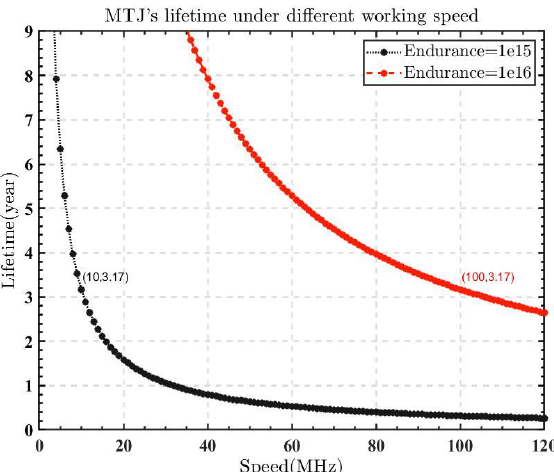
Figure 3. MTJ’s lifetime at various operating frequencies. Under a clock frequency of 10 MHz, MTJ with 1 × 10 15 endurance can operate for 3.17 years.